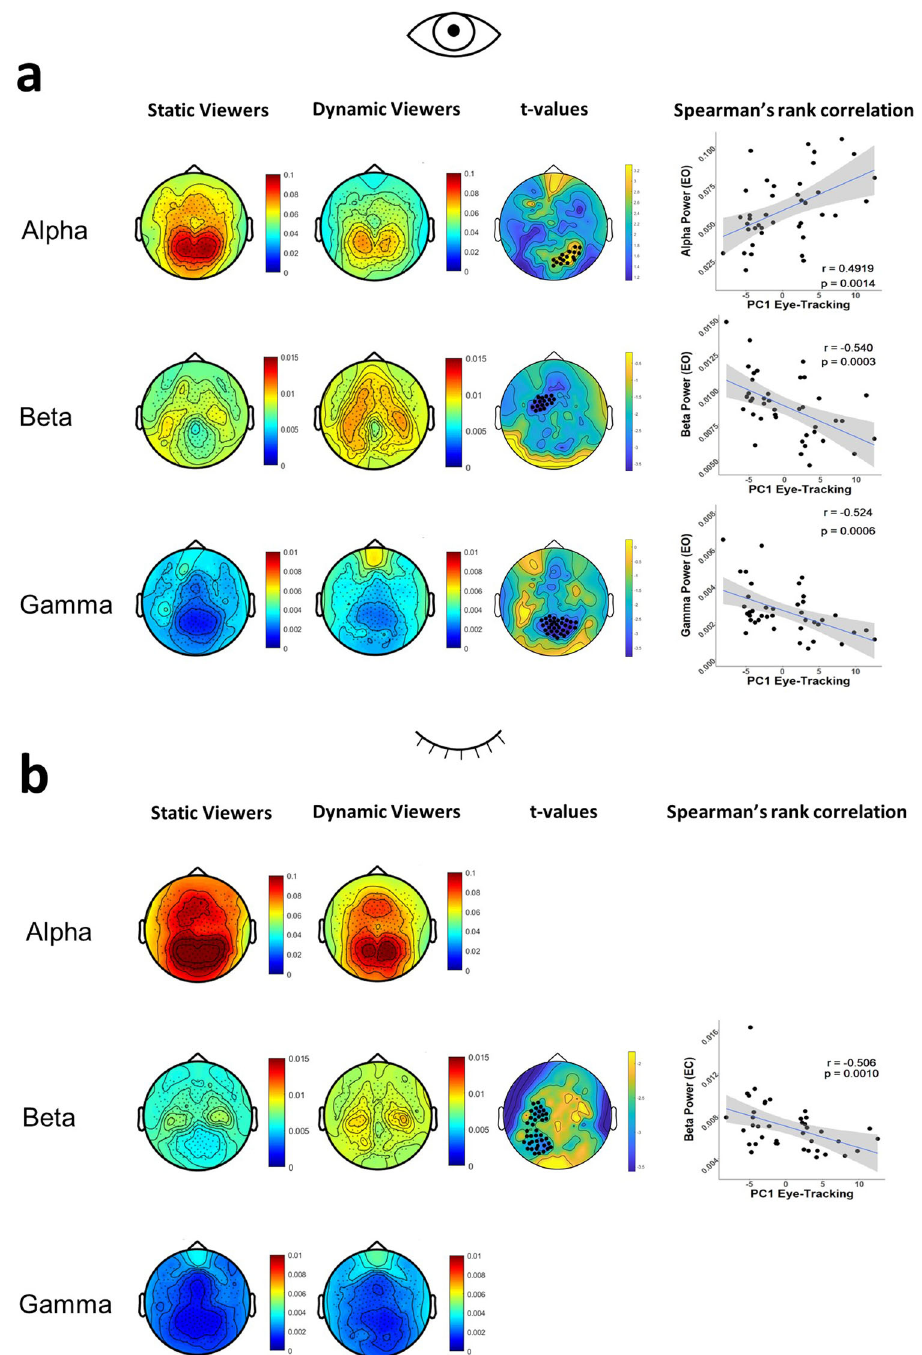
Fig. 1 Spectral analysis results. a Group scalp maps in eyes open condition for alpha (7.5 – 12Hz), beta (12.5 – 32Hz) and gamma (32.5 – 45Hz) relative power and t -value maps (where the comparison yielded signi fi cant results) for the cluster-based permutation analysis. Black dots index signi fi cance with cluster alpha at p < 0.01 (two-tailed) and alpha p < 0.05 (two-tailed). The right panel shows the Spearman ’ s rank correlation between PC1 and averaged power in the signi fi cant cluster of electrodes (with Spearman ’ s r , p -value and 95% CI). N = 40. b Group scalp maps in eyes closed condition for alpha (7.5 – 12Hz), beta (12.5 – 32Hz) and gamma (32.5 – 45Hz) relative power and t -value maps (where the comparison yielded signi fi cant results) for the cluster-based permutation analysis. Black dots index signi fi cance with cluster alpha at p < 0.01 (two-tailed) and alpha p < 0.05 (two-tailed). The right panel shows the Spearman ’ s rank correlation between PC1 and averaged power in the signi fi cant cluster of electrodes (with Spearman ’ s r , p -value and 95% CI). N = signi fi cant difference between groups ( F 1,38 = 7.31, p = 0.03; FDR corrected) (Fig. 1).